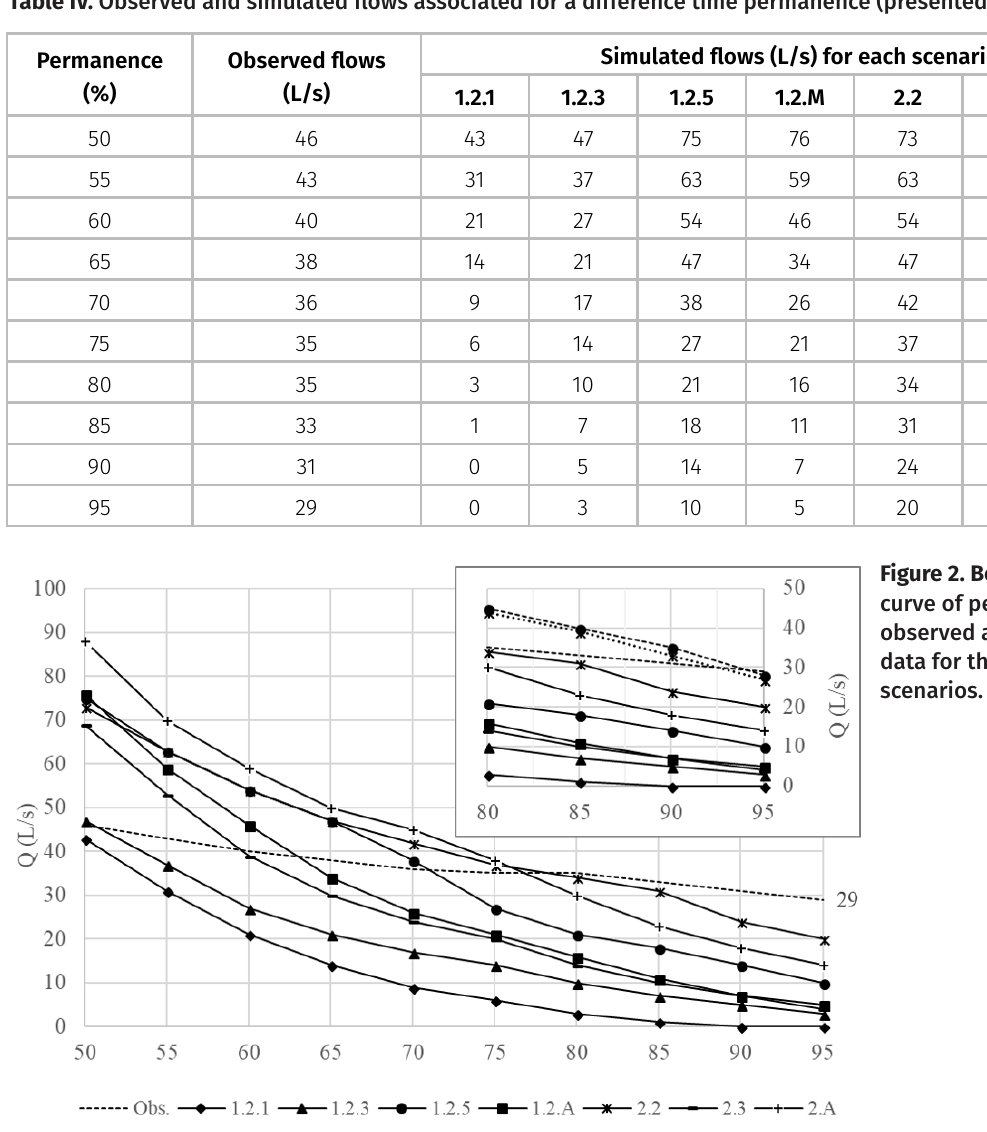
Table IV. Observed and simulated flows associated for a difference time permanence (presented in L/s).